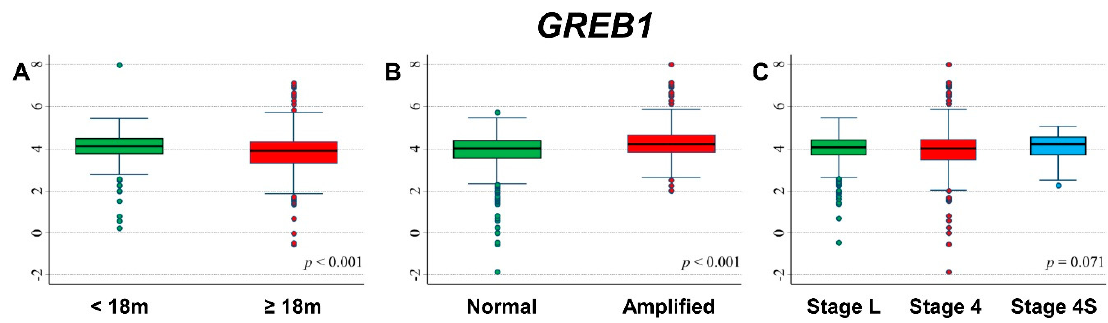
Table 16. Event Free Survival of 498 NB patients in relation to LOC339788 expression levels evaluated by the Cox model.